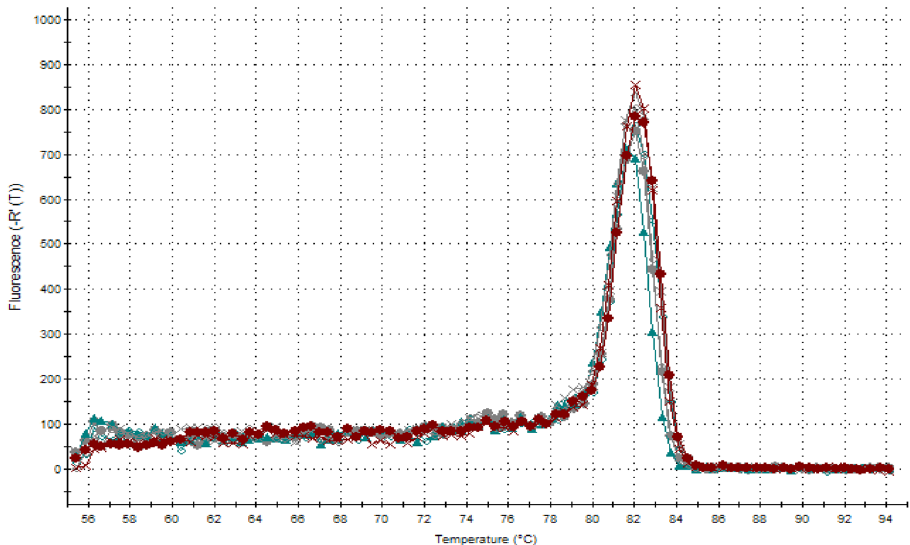
Figure 1. The melting curves of the real-time PCR amplification products of the TGFB1 gene.